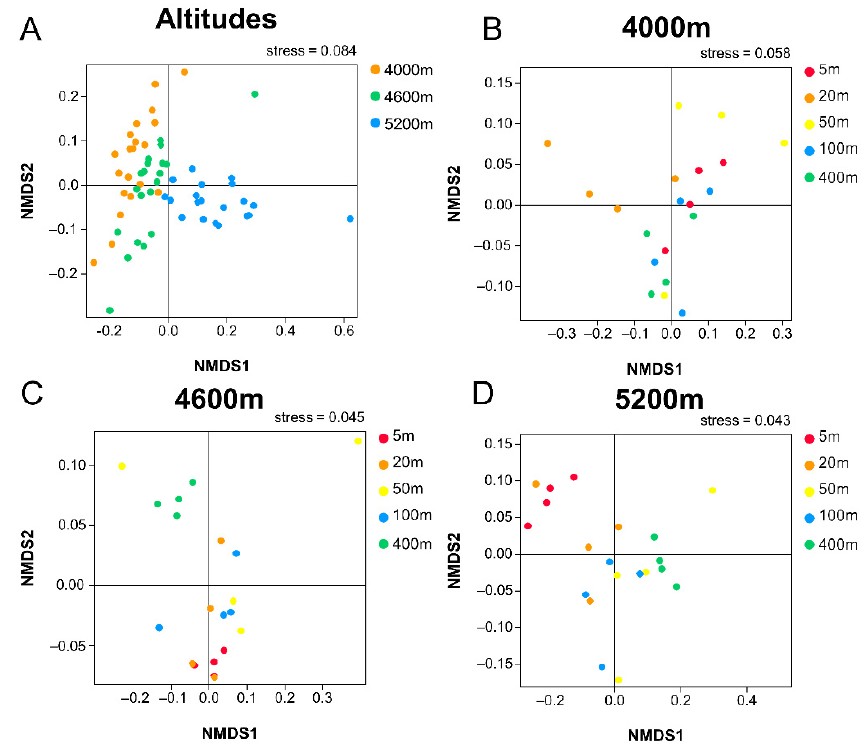
Figure 9. Non-metric multidimensional scaling (NMDS) analysis of ( A ) overall bacterial in 3 altitudes and bacterial in 3 sites of ( B ) 4000 m, ( C ) 4600 m, and ( D ) 5200 m.